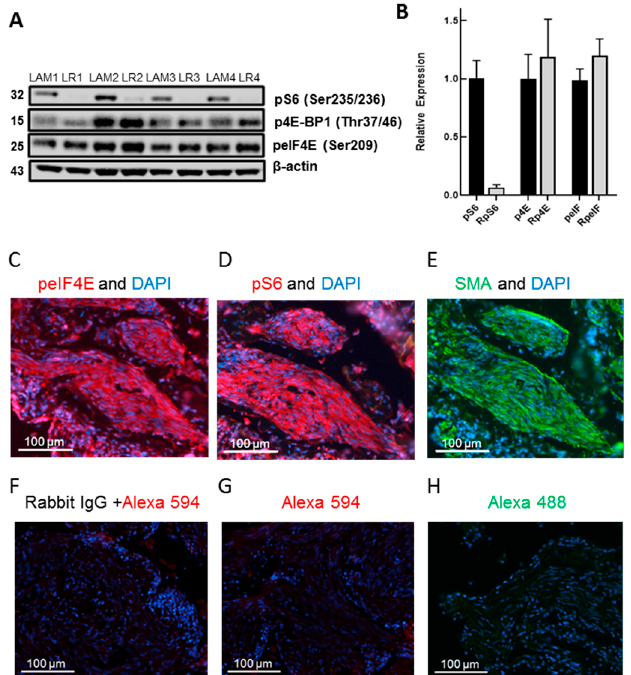
Figure 2. Rapamycin inhibition of pS6 but not p4E-BP1 or peIF4E in LAM lung-derived cell lines and peIF4E localization in LAM lung lesions. ( A ) Immunoblot of pS6 (Ser235/236), p4E-BP1 (Thr37/46), peIF4E (Ser209), and β -Actin in four independent LAM lung-derived cell lines (LAM1-LAM4), plus or minus rapamycin (10 nM) incubated for 16–18 h in a serum-deprived medium (LR1-LR4). Immunoblot analysis was as described in Materials and Methods. ( B ) Quantitation of the relative expression of immunoblot bands of pS6, p4E-BP1, and peIF4E by rapamycin-treated LAM lines relative to the control set for each protein control as one. LAM lung lesion immunofluorescent localization of ( C ) peIF4E (Ser209) (red), ( D ) pS6 (Ser235/236) (red), ( E ) α -SMA (green), ( F ) non-specific anti-IgG primary/Alexa 594 secondary (red), ( G ) Alexa 594 (red) secondary, and ( H ) Alexa 488 (green) secondary antibody.